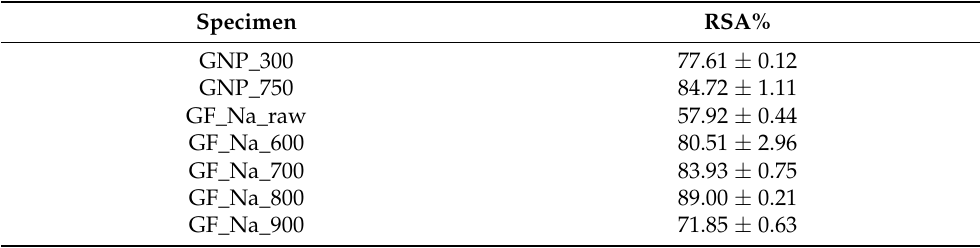
Table 4. Antioxidant activity (RSA%) of graphene